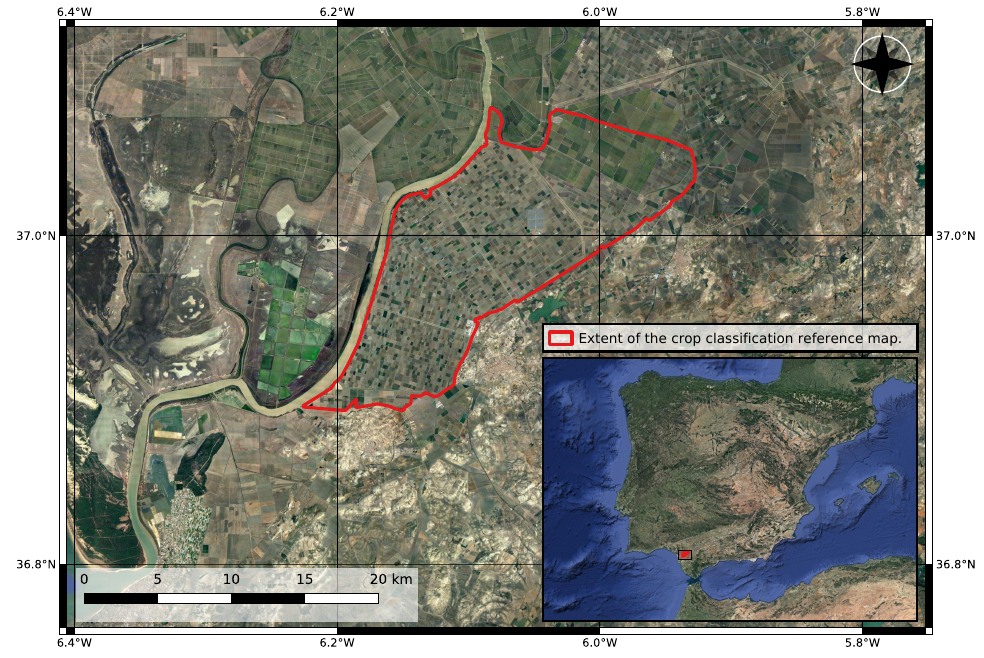
Figure 1. Map of the test site in Sevilla, Spain. The approximate extent of the area covered by the crop type map used for the study is outlined in